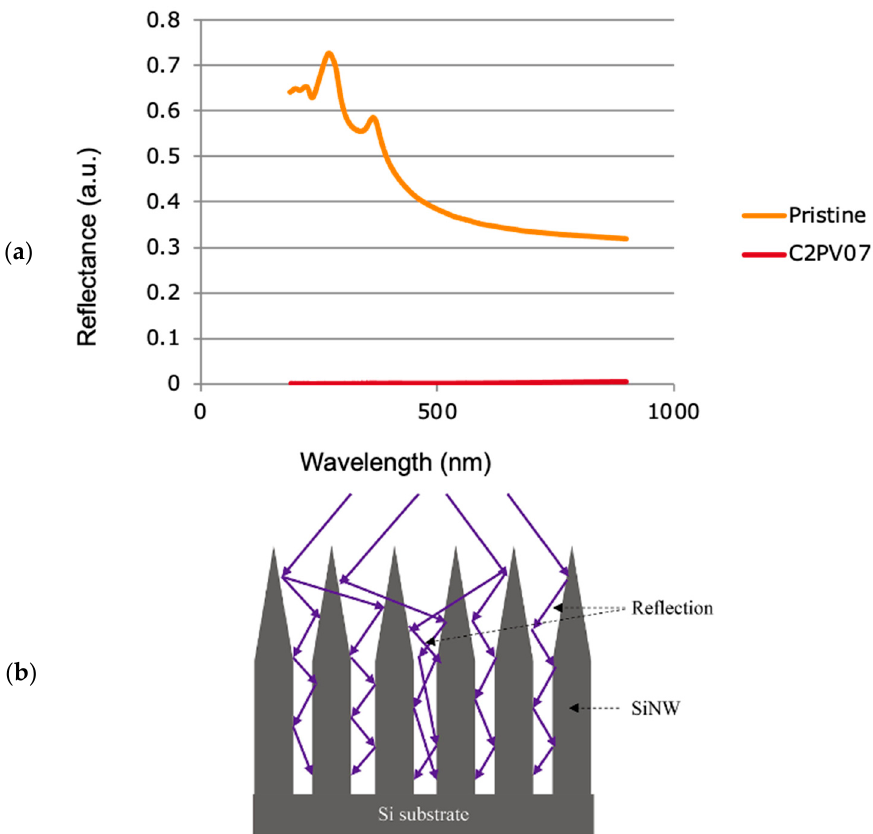
Figure 3. Si-NWs are excellent light absorbers. ( a ) The reflectance of Si-NWs is almost zero in comparison to pristine Si. ( b ) Schematic representation shows how the light rays bounce between the NWs to be absorbed eventually.